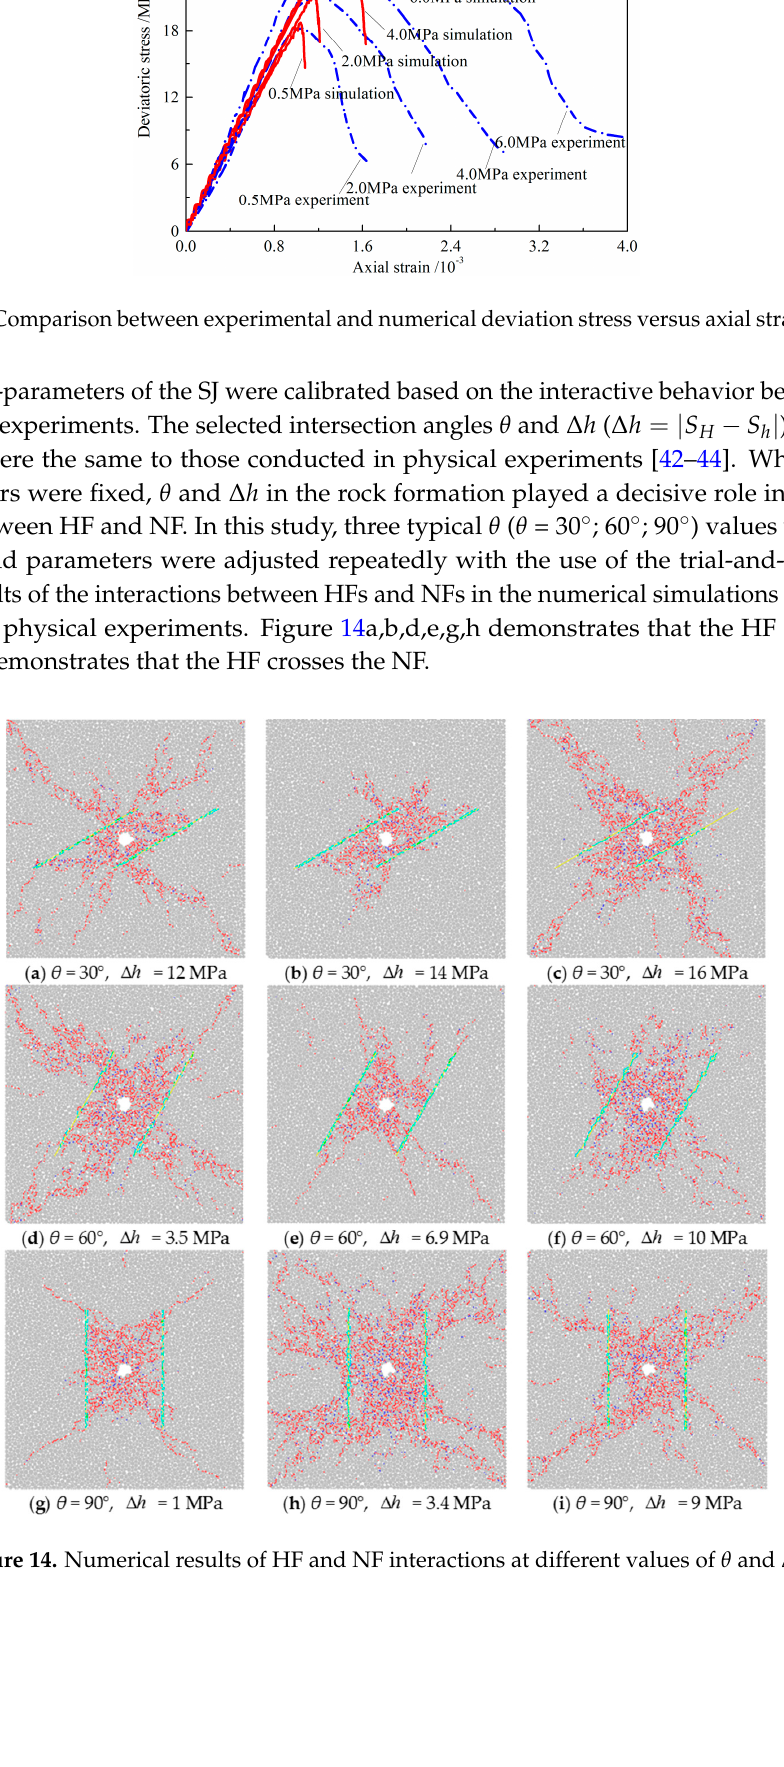
Figure 14. Numerical results of HF and NF interactions at different values of θ and